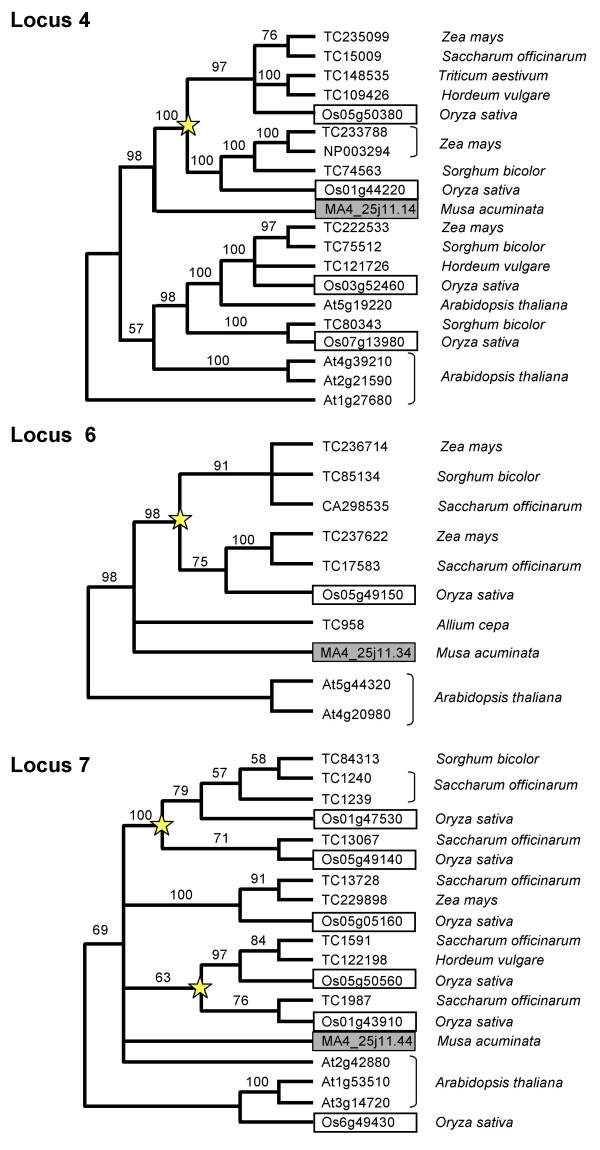
Phylogenetic analyses on three of the ten M. acuminata genes from MA4_25J11 BAC clone. These three Musa genes have homologous genes in rice chromosomes 1 and 5 and the locus numbers are taken from Figure 5B. Stars indicate duplication events in the most recent common ancestor of major grain lineages (i.e. rice, wheat and maize). MA4_25J11 BAC clone was isolated by the SbRPG132 probe.